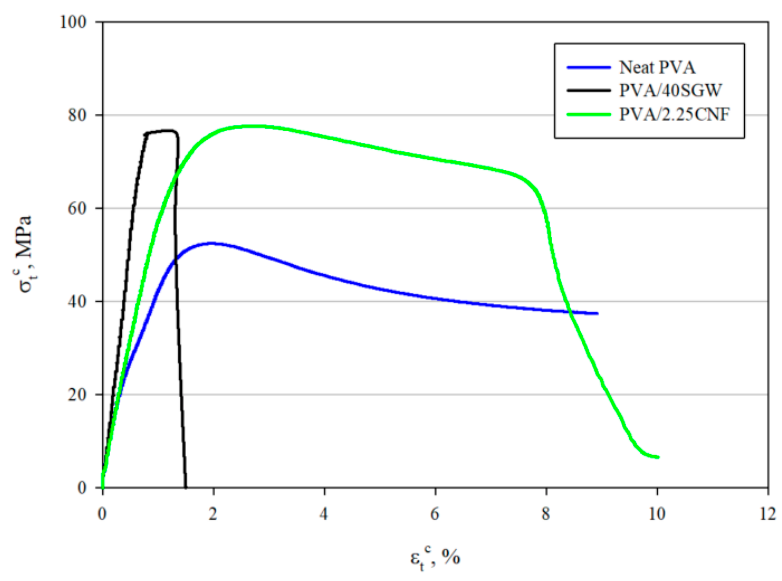
Figure 3. Stress-strain curves of neat PVA and PVA/2.25CNF and PVA/40SGW composites.